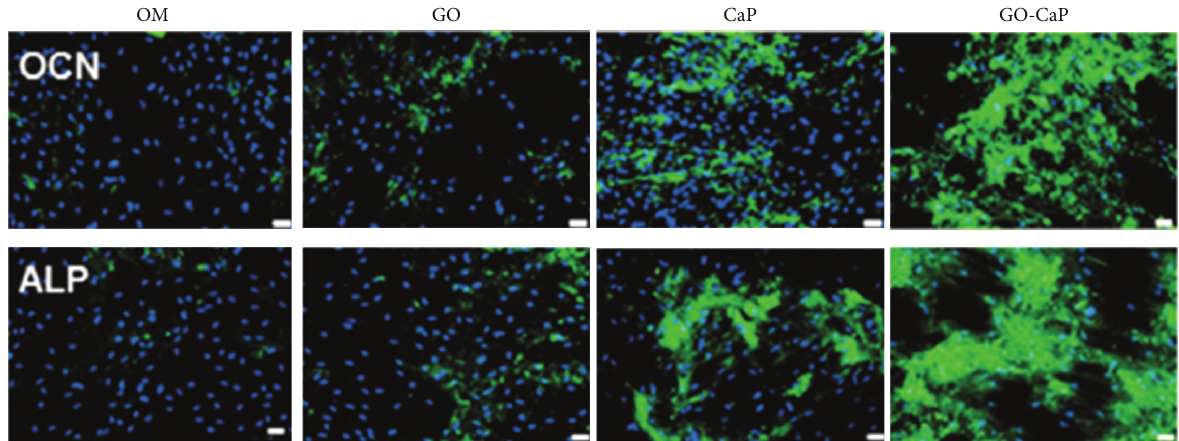
Figure 6: Immunofluorescence for osteocalcin and alkaline phosphatase (green) and DAPI (blue) after incubation with control osteogenic medium on GO, calcium phosphate (CaP), and GO–CaP for two weeks. Scale bars represent 20 mm. Reprinted with permission from [73] (Copyright (2014) American Chemical